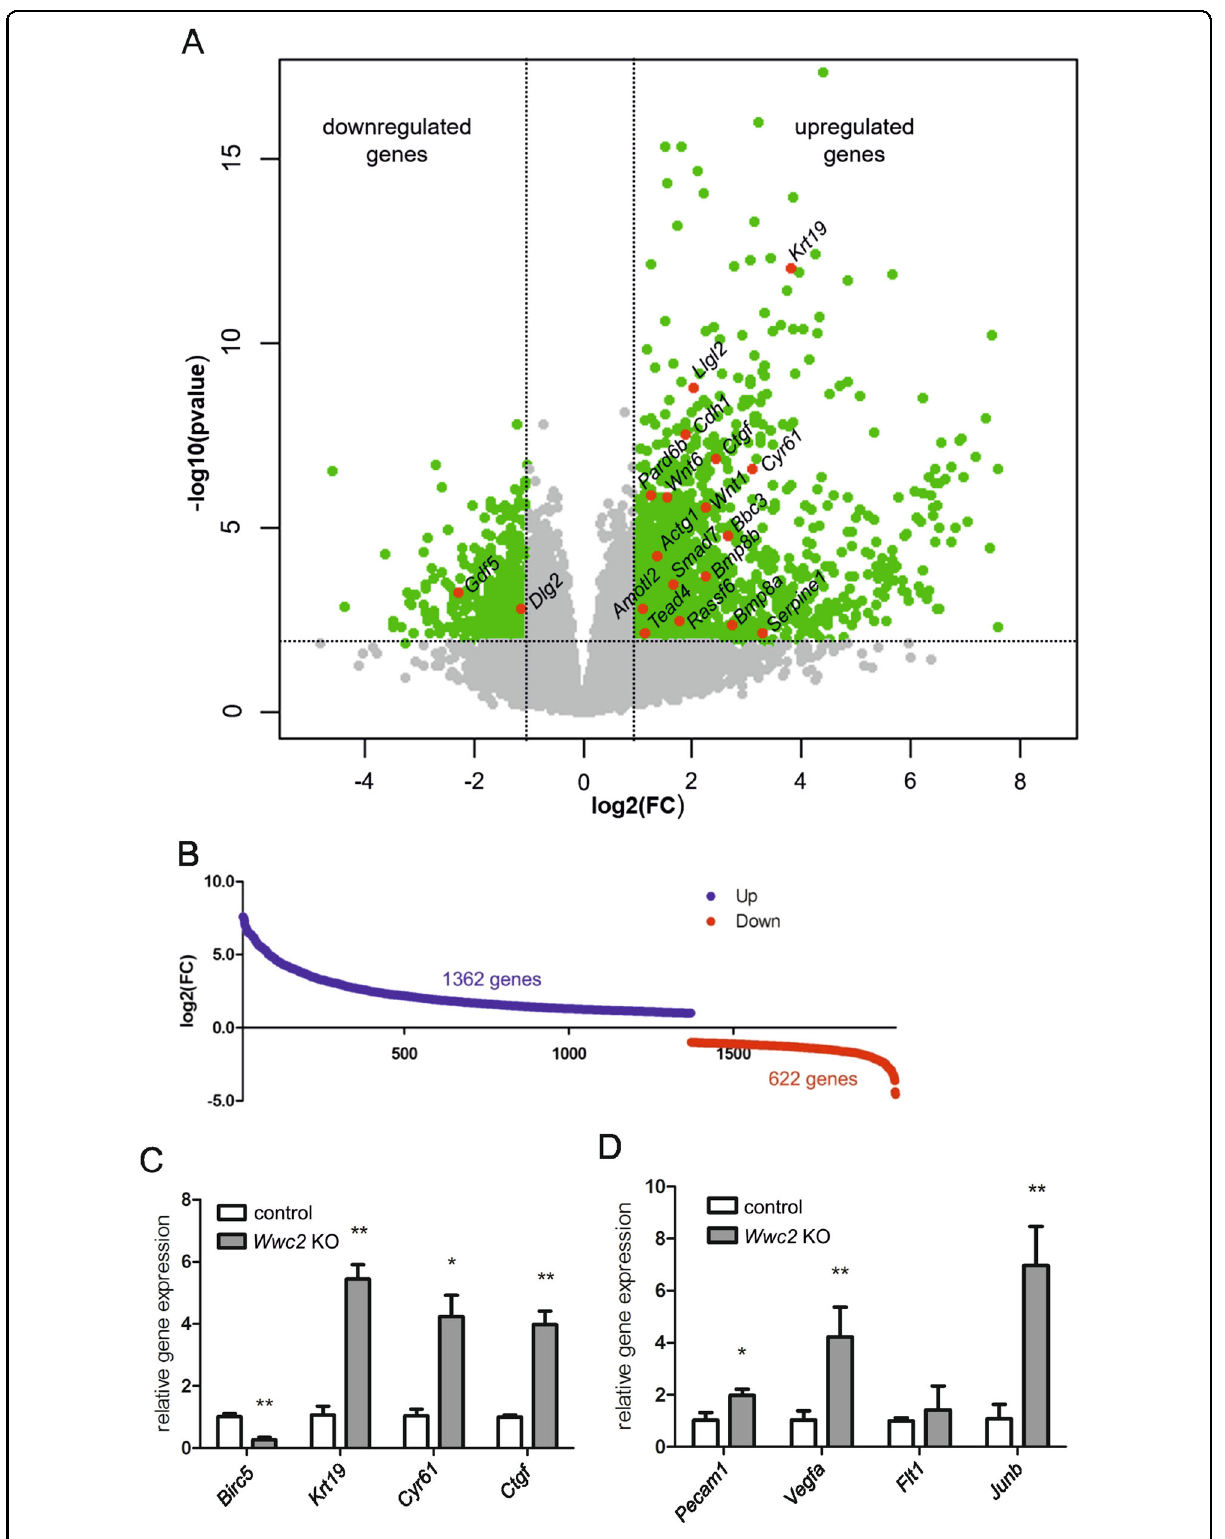
Fig. 5 (See legend on next